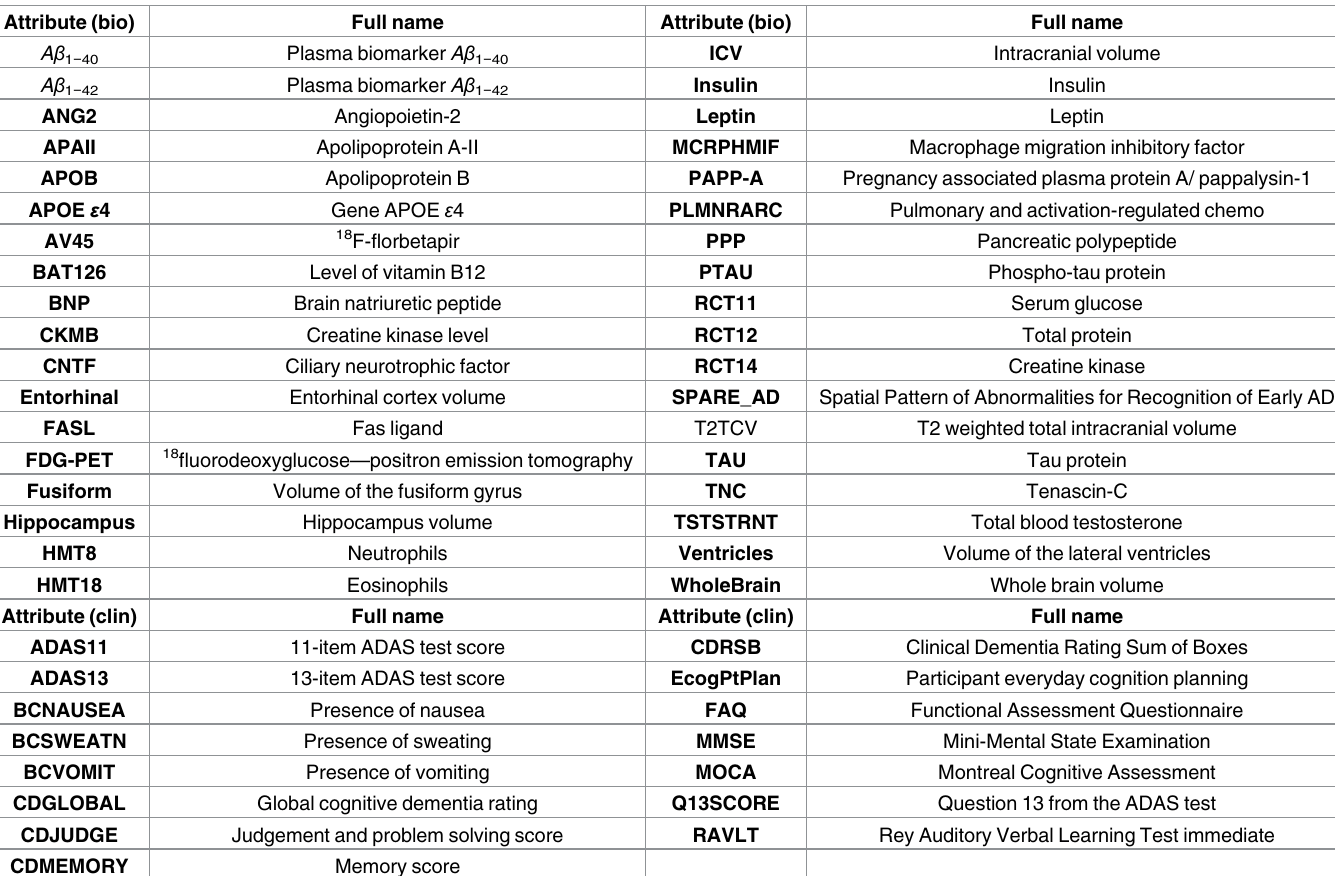
Table 2. A list of clinical and biological attributes discussed in the